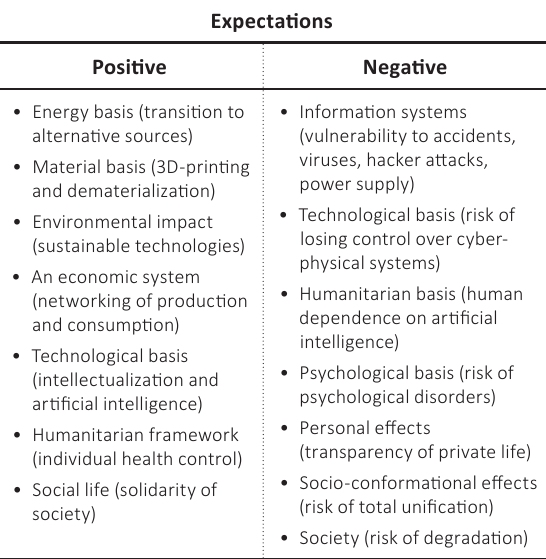
Table 2. “Horizons” (expected socio-economic effects) of the additive